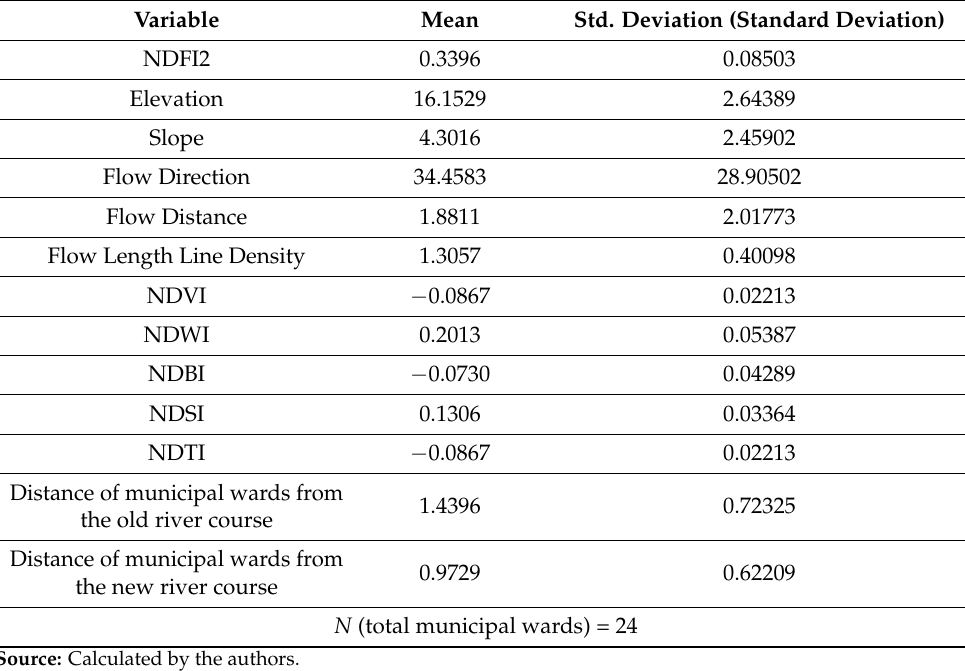
Table 8. Descriptive statistics of the selected variables (2015).